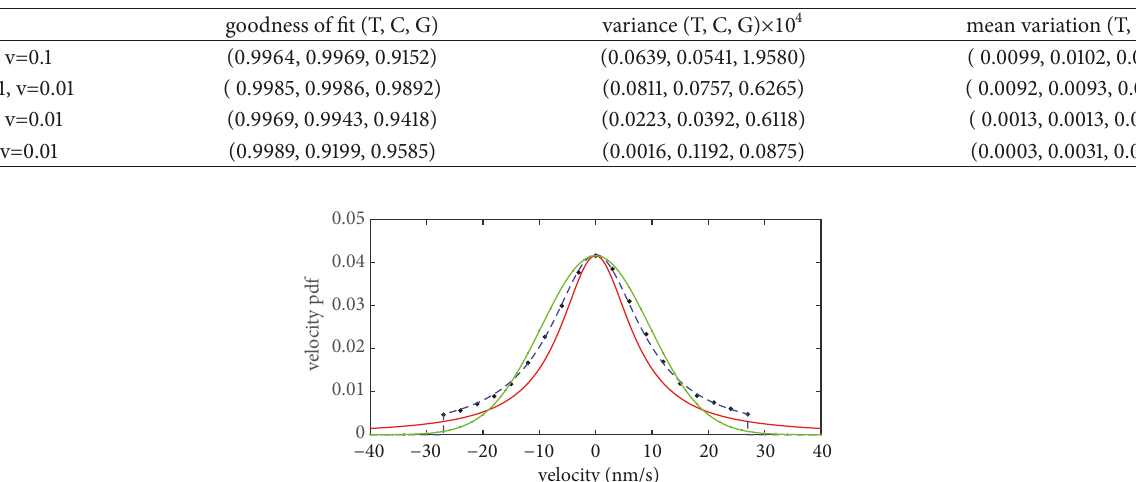
Table 1: Three indexes of the distributions in different conditions of tunneling current and bias voltage, where 𝑇 represents truncated Cauchy- Lorentz distribution, 𝐶 means Cauchy distribution, and 𝐺 is the Gaussian distribution.